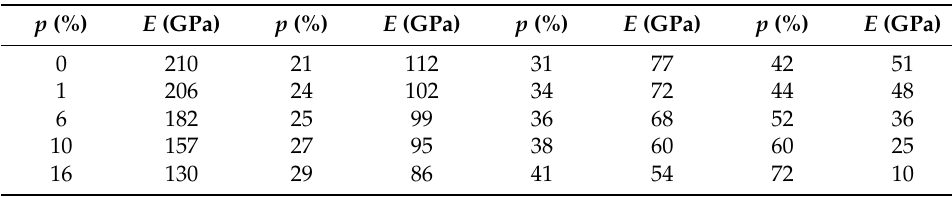
Table 3. The engineering elastic modulus of lotus-type iron in transversal direction to pores, obtained computationally with indirect model